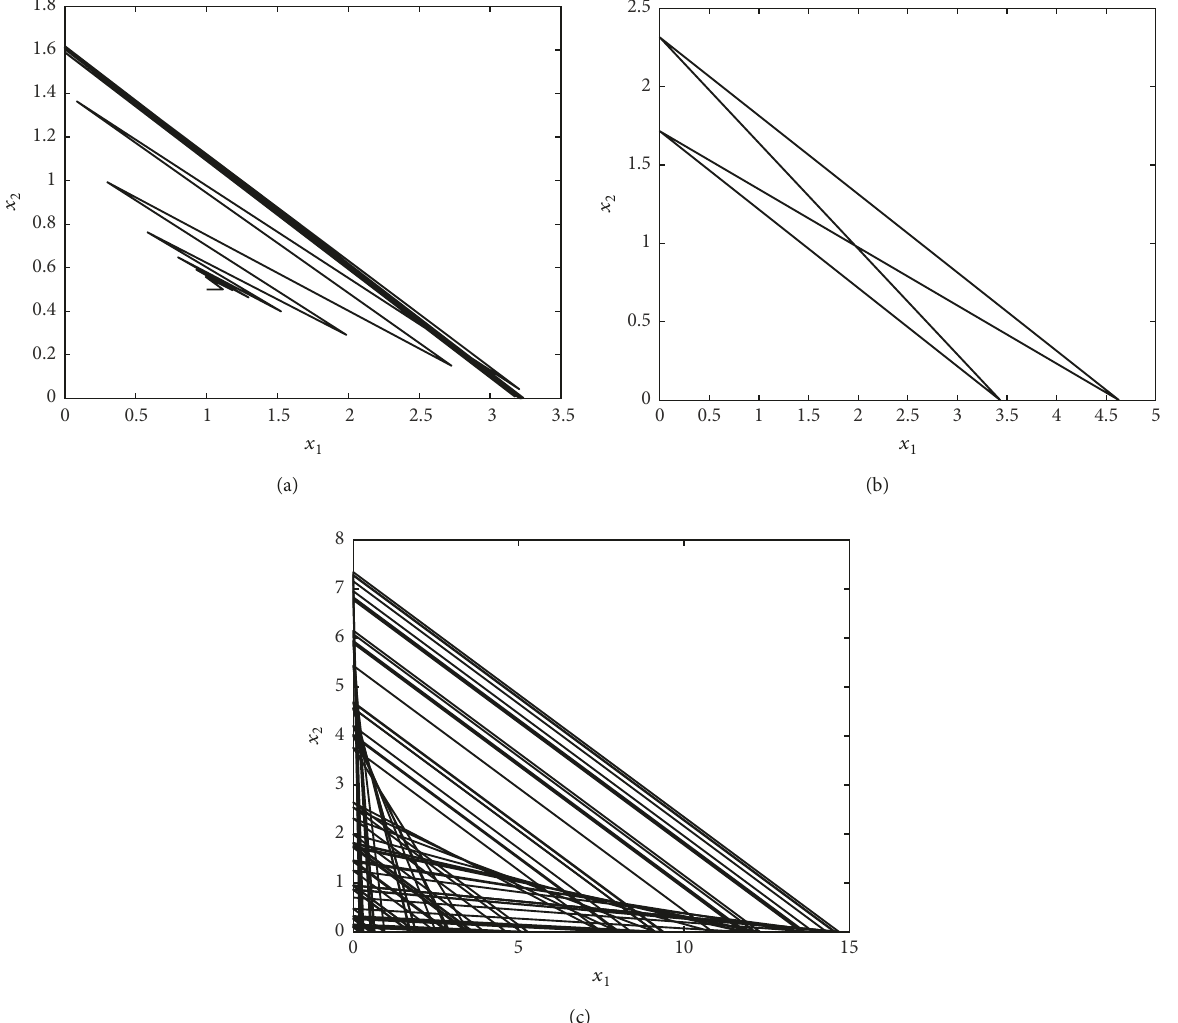
Figure 4: (a) Convergence to a 2 -cycle of SYC form. (𝑃,𝐹) = (0.5,10) . (b) A 4 -cycle of SYC form. (𝑃,𝐹) = (0.5, 15) . (c) Chaotic SYC dynamics. (𝑃,𝐹) = (0.5, 40)